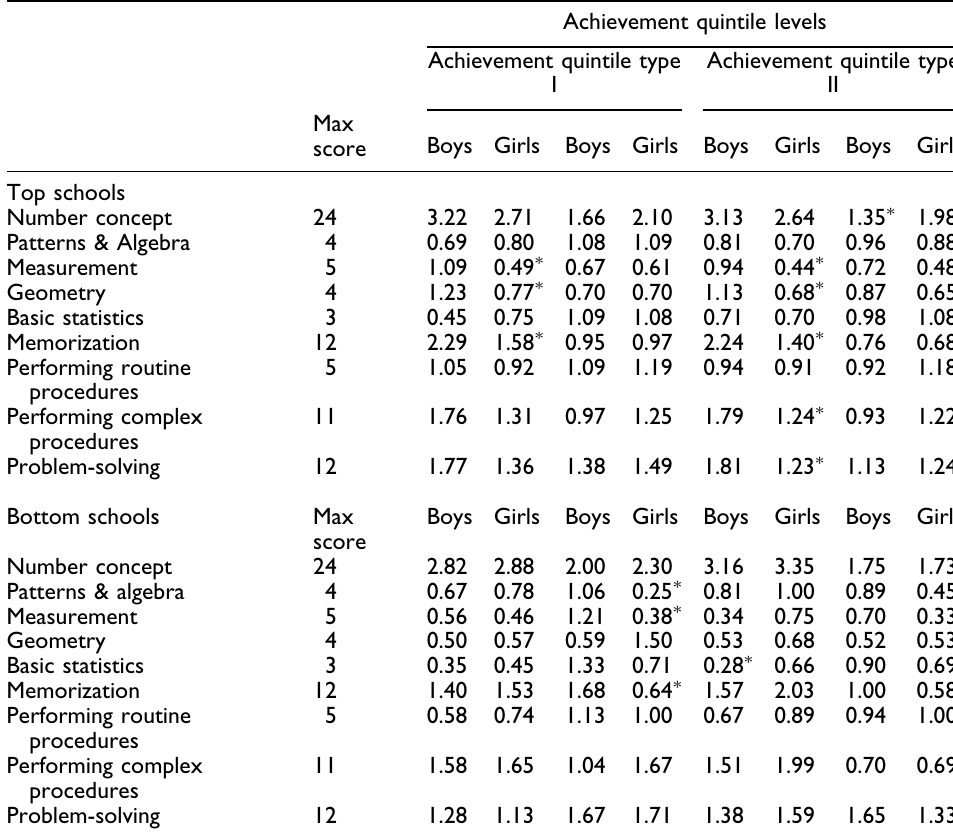
Table 3. Gender gaps by achievement quintiles Achievement quintile levels Achievement quintile type